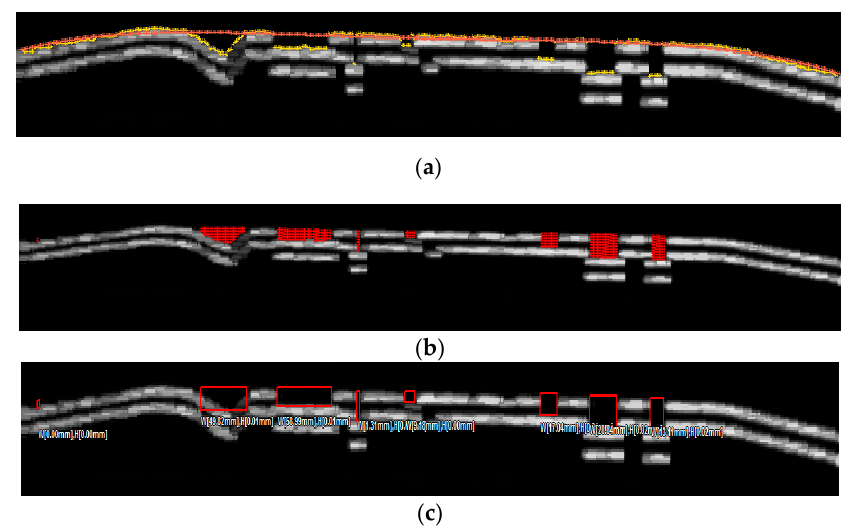
Figure 14. Post-processing for measurements of the contact strip: ( a ) overlay of laser line and base line, ( b ) extraction of the wear size between the base line and laser line, and ( c ) size determination via blob processing.